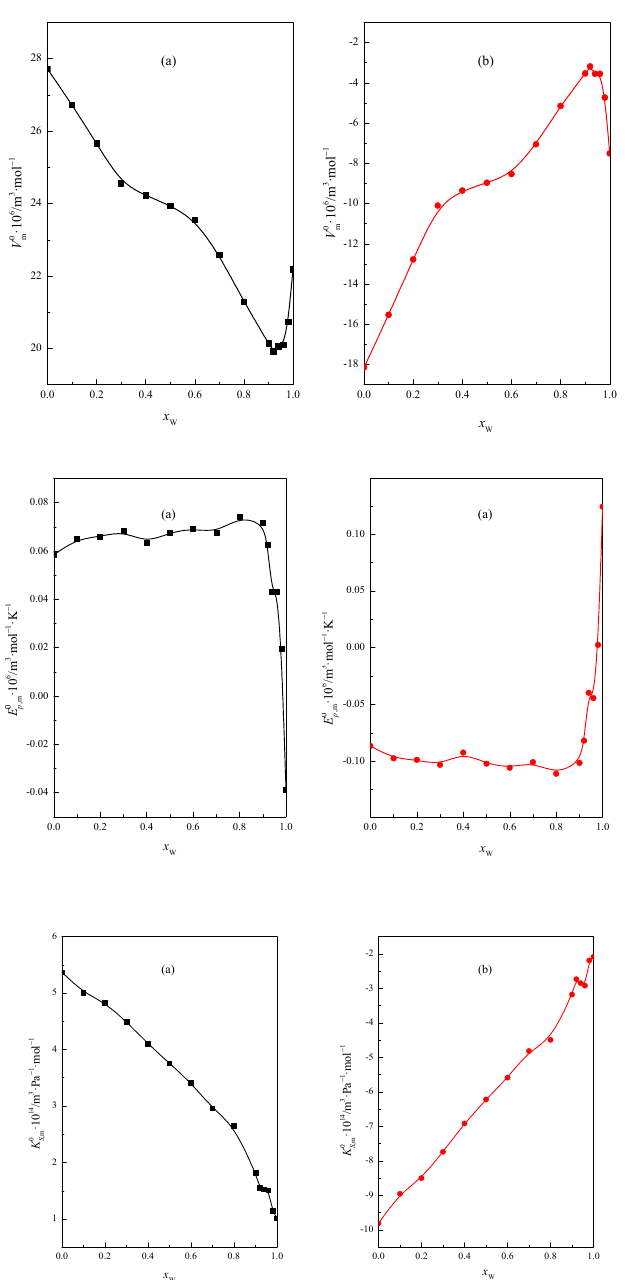
Figure 11. The average effect of interaction between the ( a ) –CH 2 – ( (cid:4) ) or ( b ) –O– ( • ) group and molecules of the DMF + W mixed solvent for the values of V 0 m , E 0 p ,m , and K 0 of x W at 298.15